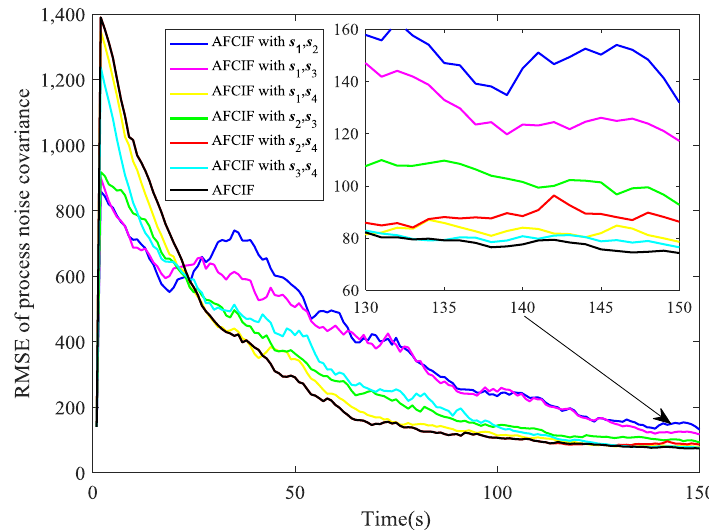
Figure 8. Comparison of RMSE (noise estimation) when the initial process noise covariance is set to be larger than the true value.